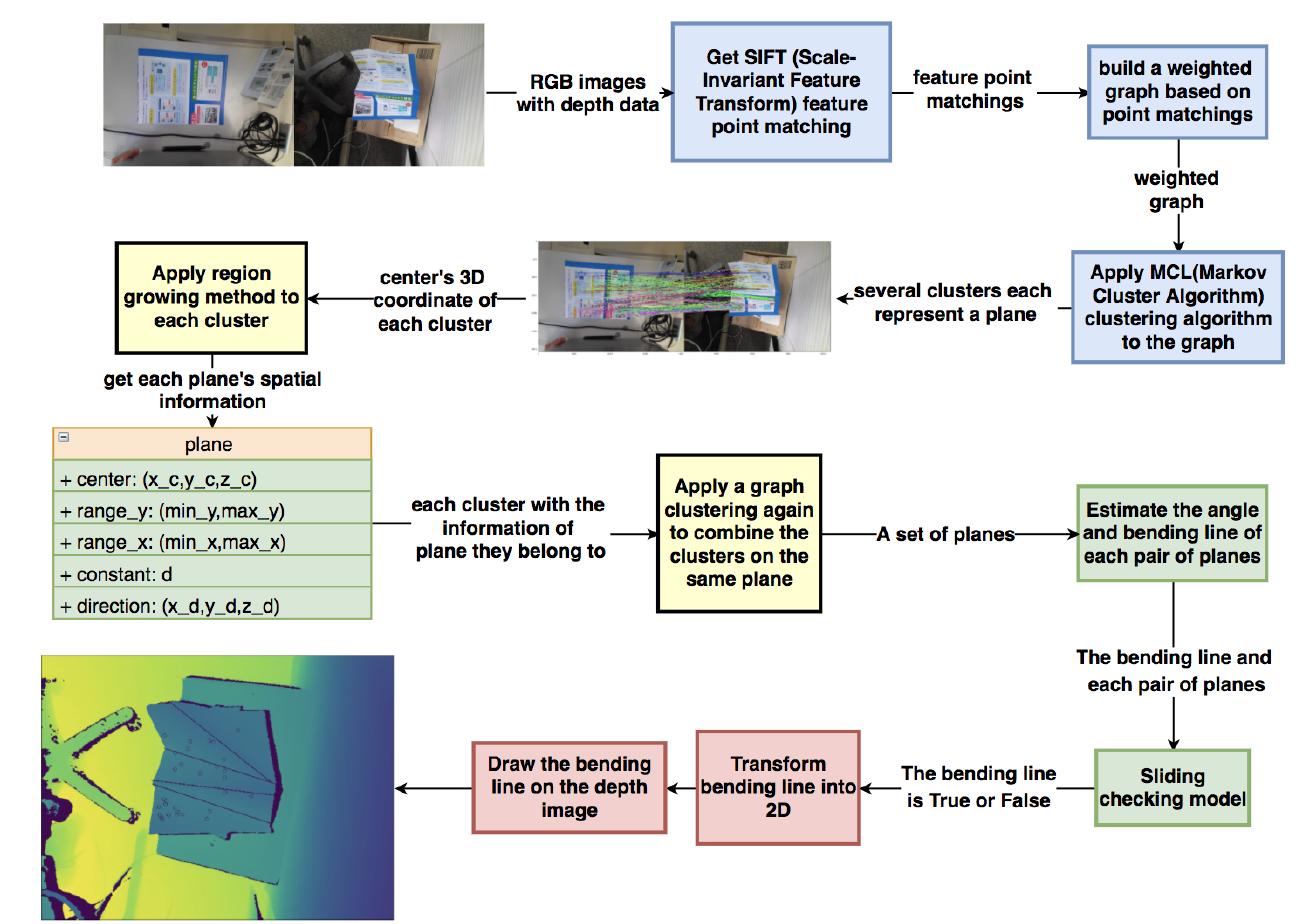
Figure 1. Outline of the proposed